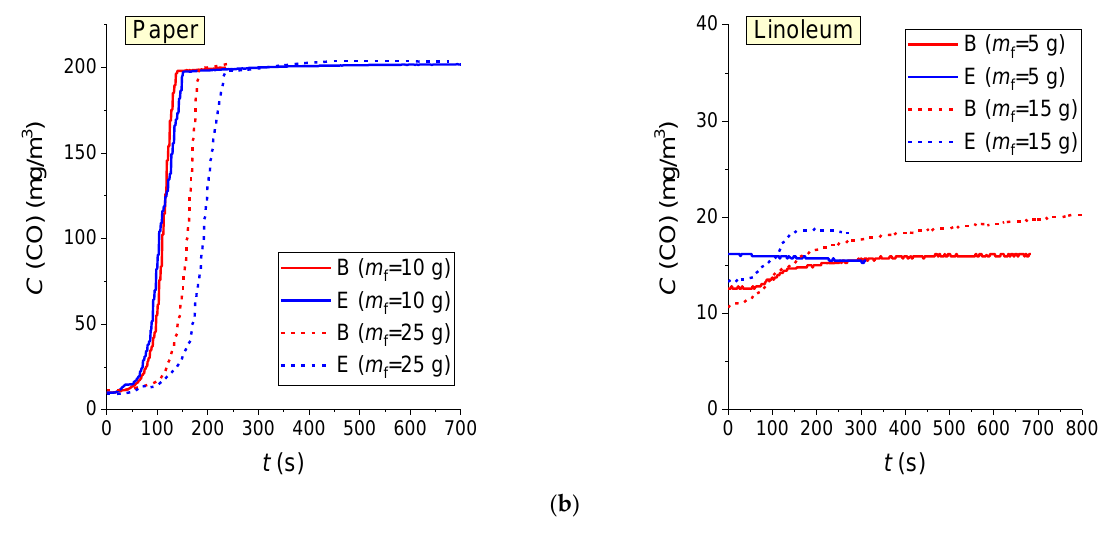
Figure 13. Trends of CO concentrations for the model fires under study when reproducing the conditions of careless handling of fire (gas burner) ( a ) and improper use of heating equipment (hot plate) ( b ), obtained using GDS (B – experimental results for the thermal decomposition of the model fire without suppression; E – experimental results for extinguishing the model fire during thermal decomposition).